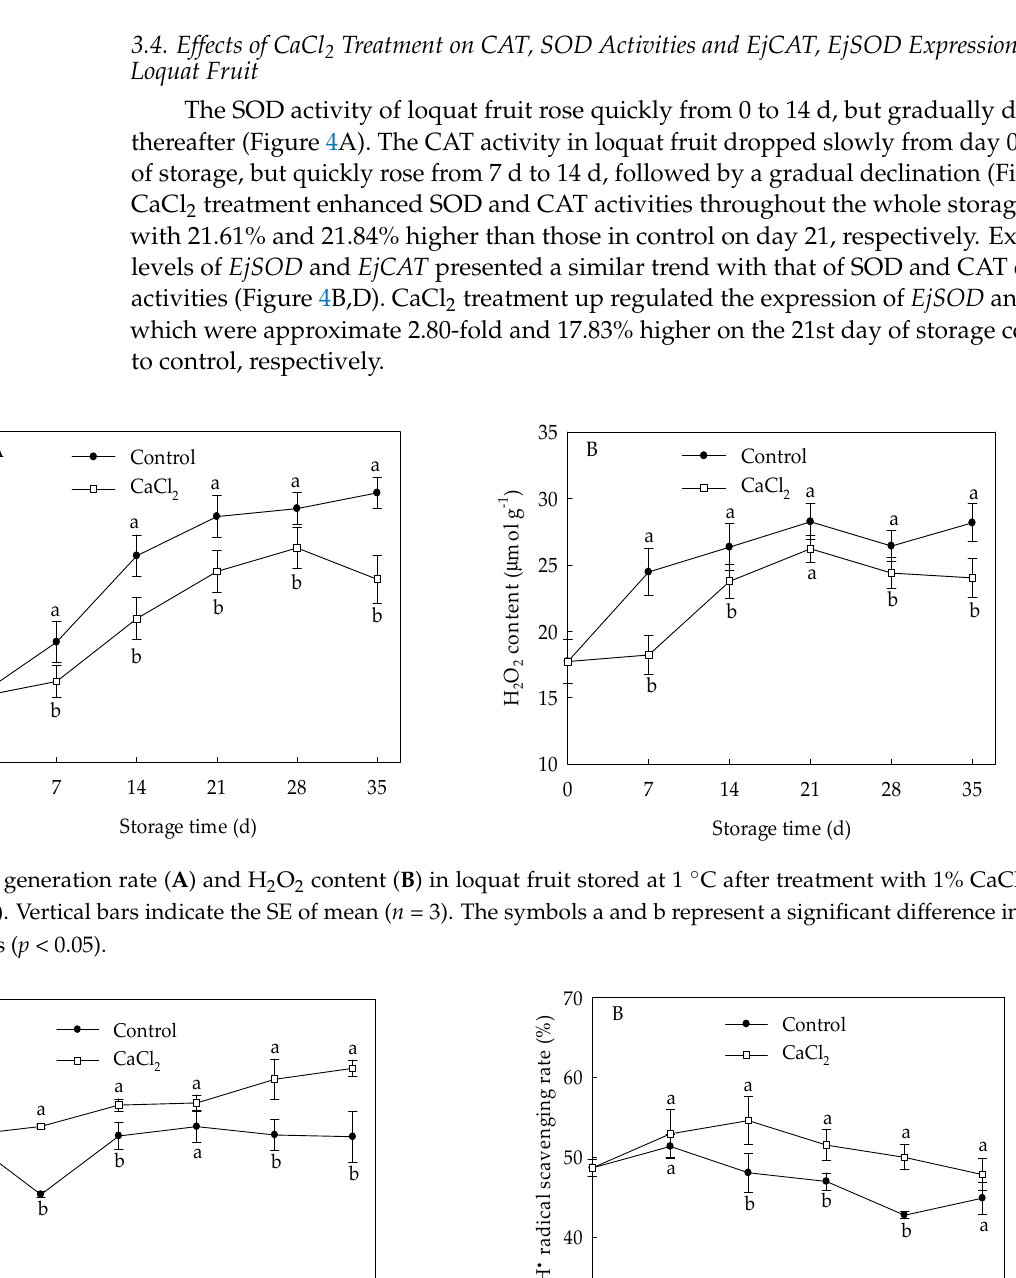
Figure 3. DPPH ( A ) and OH • ( B ) radical scavenging capacity in loquat fruit stored at 1 °C after treatment with 1% CaCl 2 or water (control). Vertical bars indicate the SE of mean ( n = 3). The symbols a and b represent a significant difference in the two treatments ( p < 0.05).